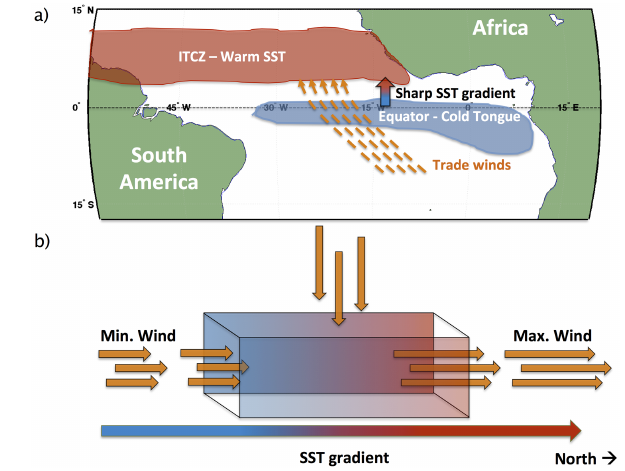
Figure 1. (a) A schematic map of the main tropical Atlantic players from May to August. (b) A north–south cross section along the nar- row band between the equatorial cold tongue and the Intertropical Convergence Zone (ITCZ) showing acceleration of the trade wind path along the sharp sea-surface temperature (SST) gradient which imposes surface wind divergence.